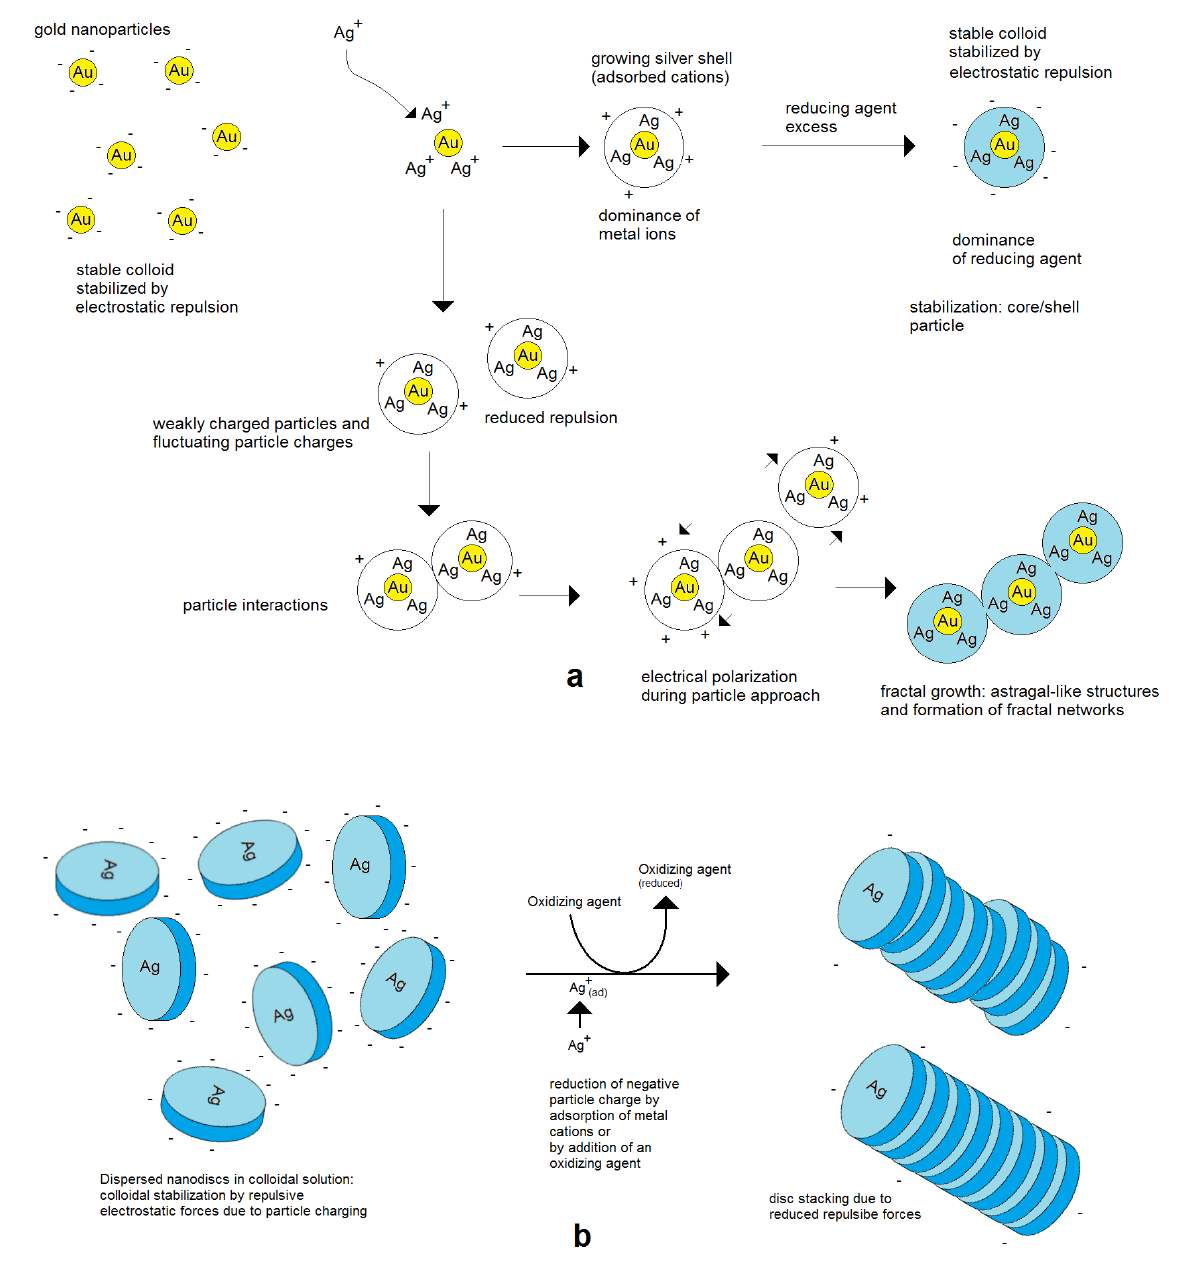
Figure 7. Assembly behavior of charged metal nanoparticles: ( a ) spherical nanoparticles; ( b ) nonspherical metal nanoparti- cles, for example